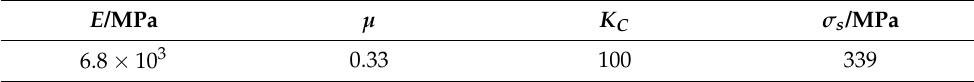
Table 1. Material parameters of LY12-CZ.